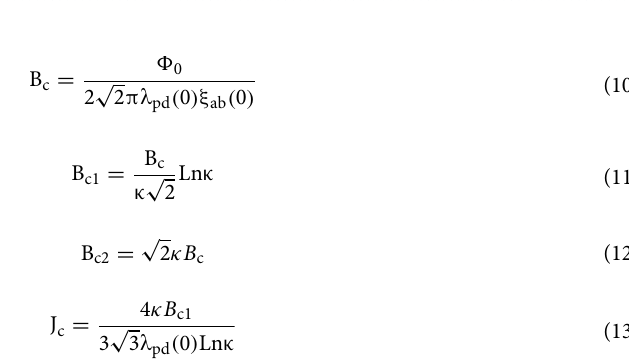
Figure 4. Variations of the estimated values for ( a ) critical current density J c (0), thermodynamic magnetic field B c (0), lower and upper critical magnetic fields B c1 (0) and B c2 (0), ( b ) coherence length along c axis ξ c (0), penetration depth λ pd (0), Fermi velocity v F and Fermi energy E F of charge carriers and inter-layer coupling strength J, as a function of the ZnO NPs added concentration. The solid lines are to guide the